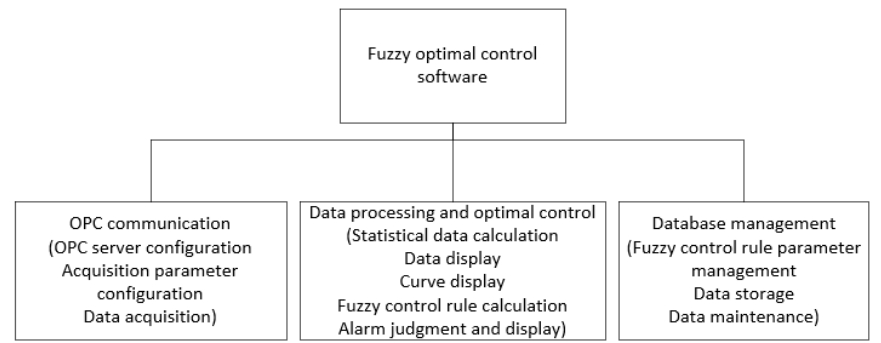
Figure 5. Optimize the function design of control software.